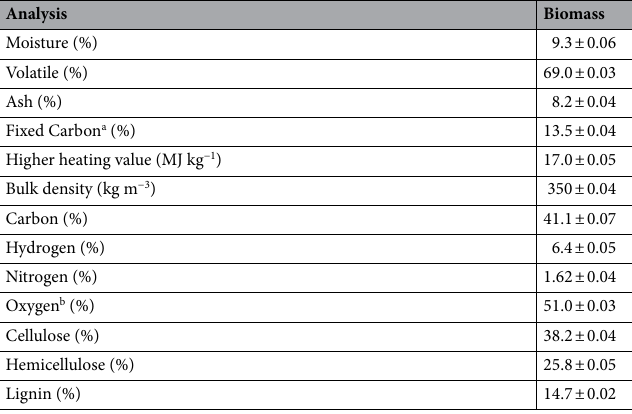
Table 1. Colored cotton waste biomass characterization. a Determined by difference, fixed carbon% = 100% − moisture% − volatile% − ash%. b Determined by difference, O% = 100% − carbon% − hydrogen% −